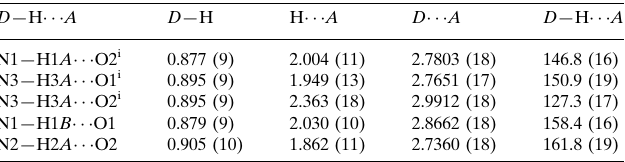
Hydrogen-bond geometry (A˚ , (cid:4)